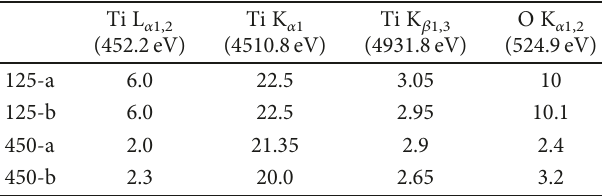
Table 3: Energy-dispersive X-ray intensities (cps) for samples processed at di ff erent